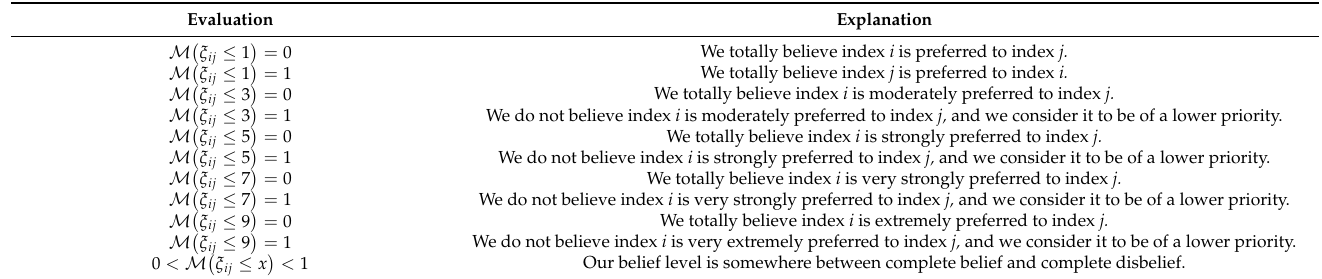
Table 1. Pairwise comparison scale 1